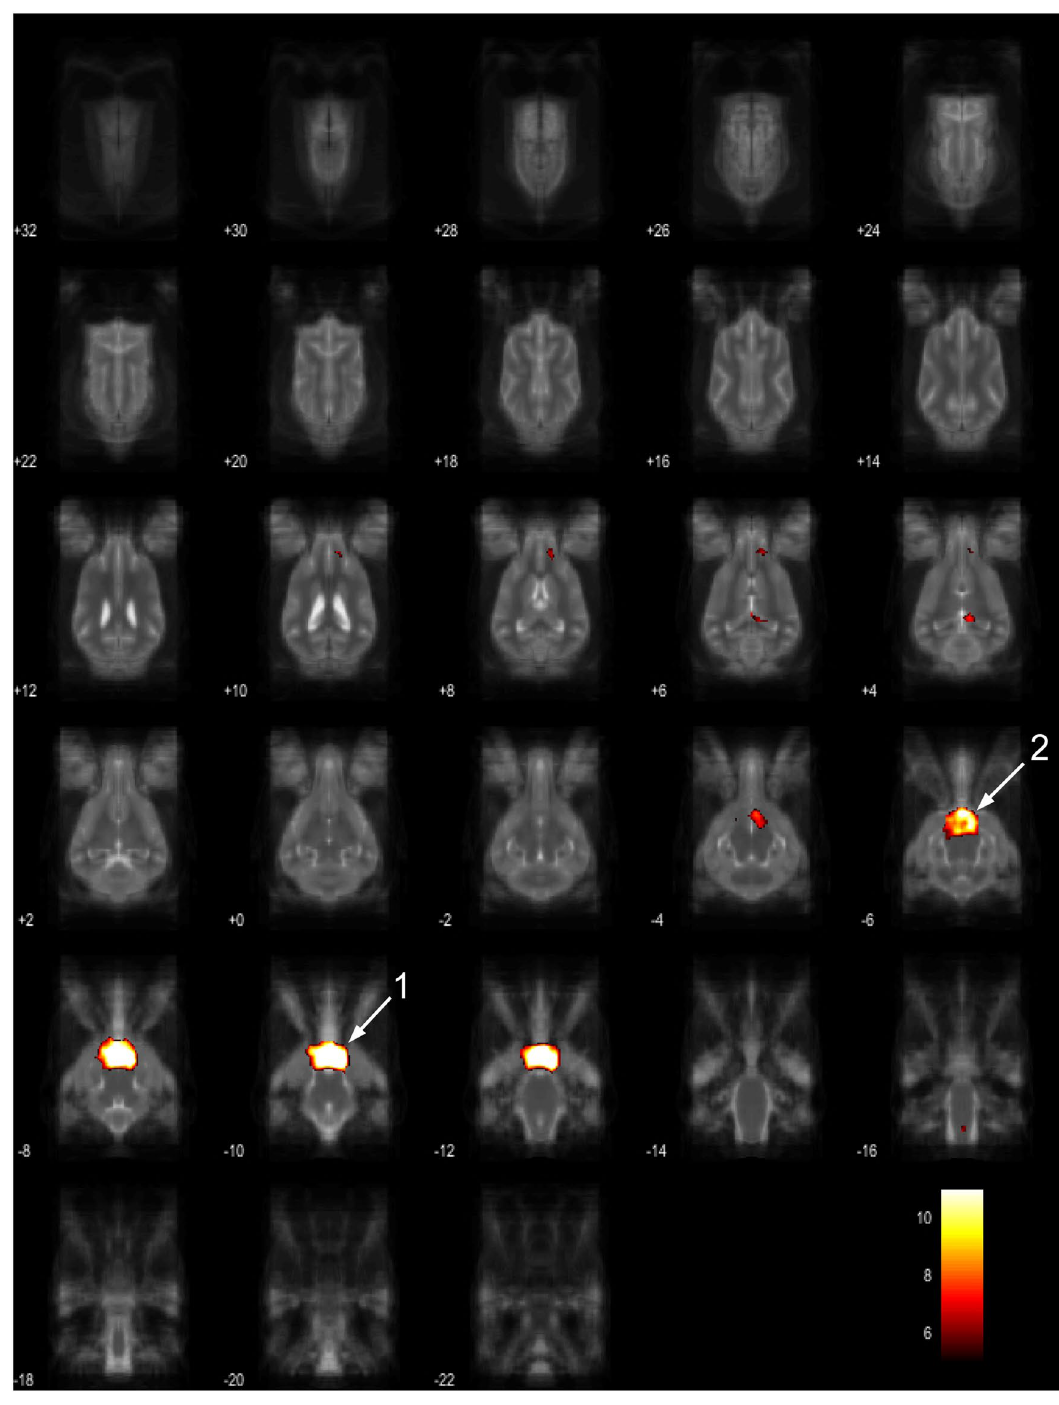
Figure 17. Resting-state network component N from the 15 component gICA. We report the results with a voxel-wise FDR corrected p < 0.001 and cluster treshold of FDR corrected p < 0.005. gICA components are presented as thresholded T-maps, corrected for multiple comparisons, overlaid on the Nitzsche atlas 15 . 1. sinus cavernosus, 2. Willis’